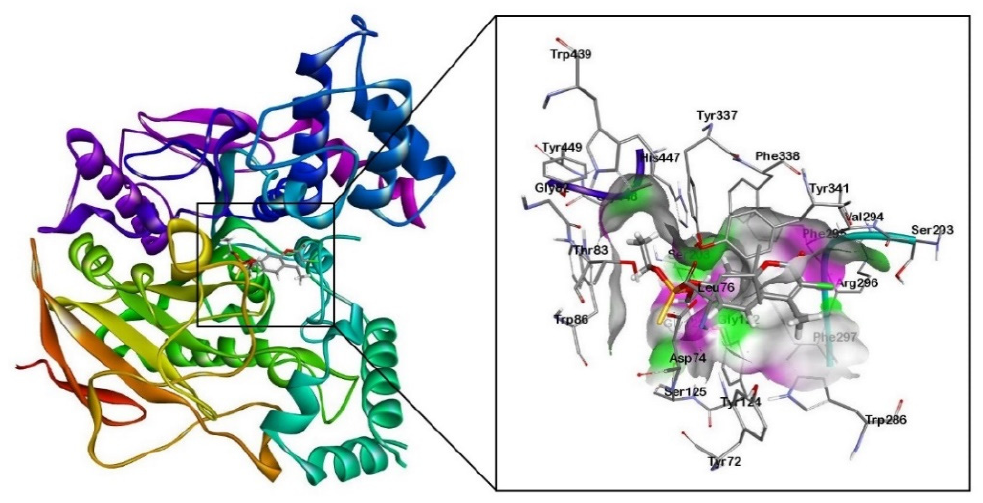
Figure 1. Molecular docking results of human AChE enzyme (PDB: 4PQE ) with organophosphorus pesticide coumaphos ( Cou ).